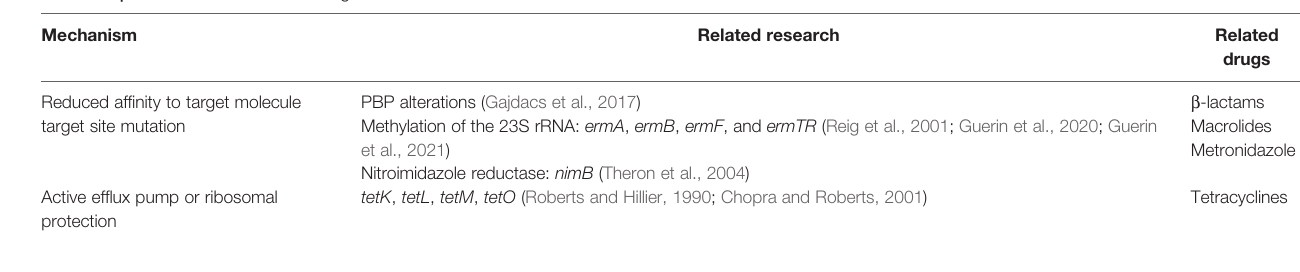
TABLE 3 | The main mechanism of drug resistance in